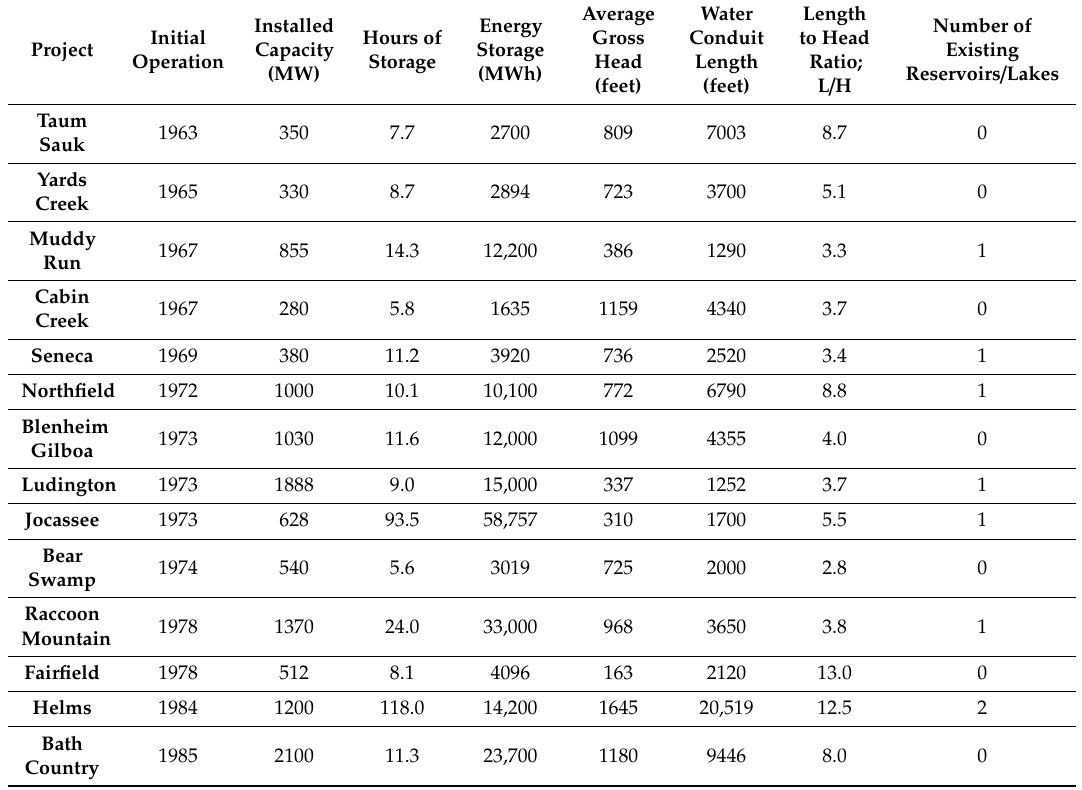
Table 2. Existing pumped hydro storage projects in the United States